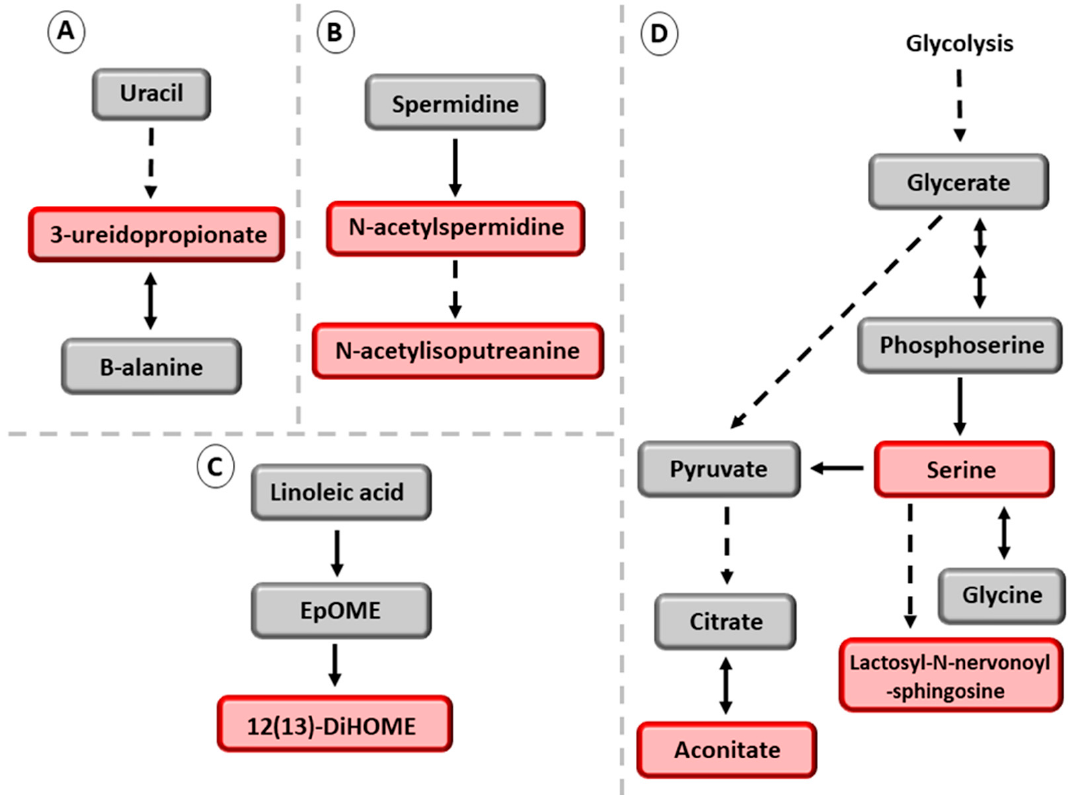
Figure 2. Novel metabolites associated with PNPLA3 rs738409-G in men with NAFLD. Red color indicates increased concentration of the metabolites. Grey color indicates that these metabolites were not significantly associated with PNPLA3 rs738409-G. A . metabolites belonging to the uracil pathway. B . downstream metabolites belonging to the spermidine pathway. C . downstream